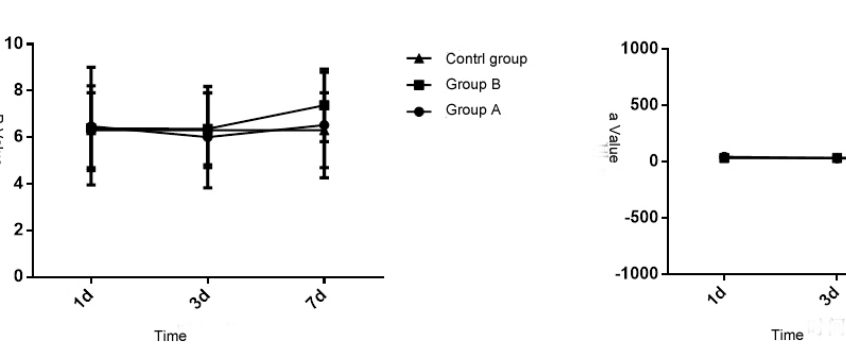
Figure 1: Comparative analysis of r value of the patients in the three groups at different times